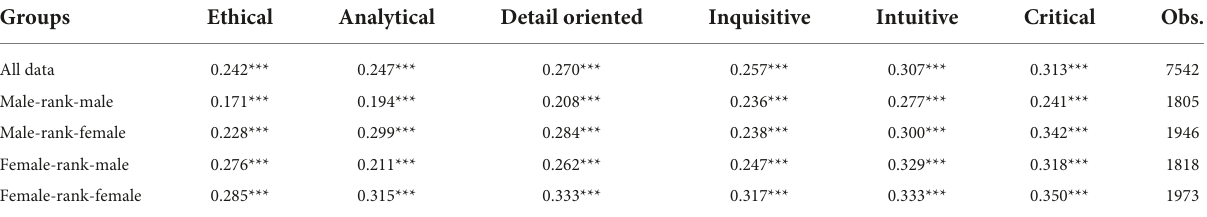
TABLE 7 Correlations between attractiveness and other perceived